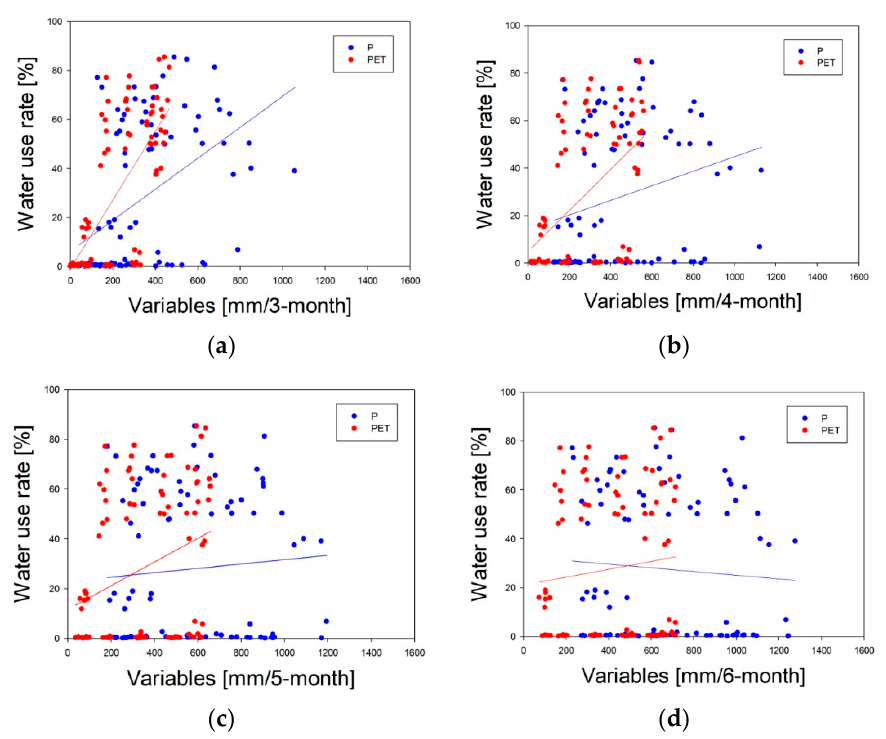
Figure 6. Scatter plots describing the relationships among precipitation and potential evapotranspiration and stream water-use rate for different cumulative durations. ( a ) 3-month cumulative; ( b ) 4-month cumulative; ( c ) 5-month cumulative; ( d ) 6-month cumulative. cumulative; ( c ) 5-month cumulative; ( d ) 6-month